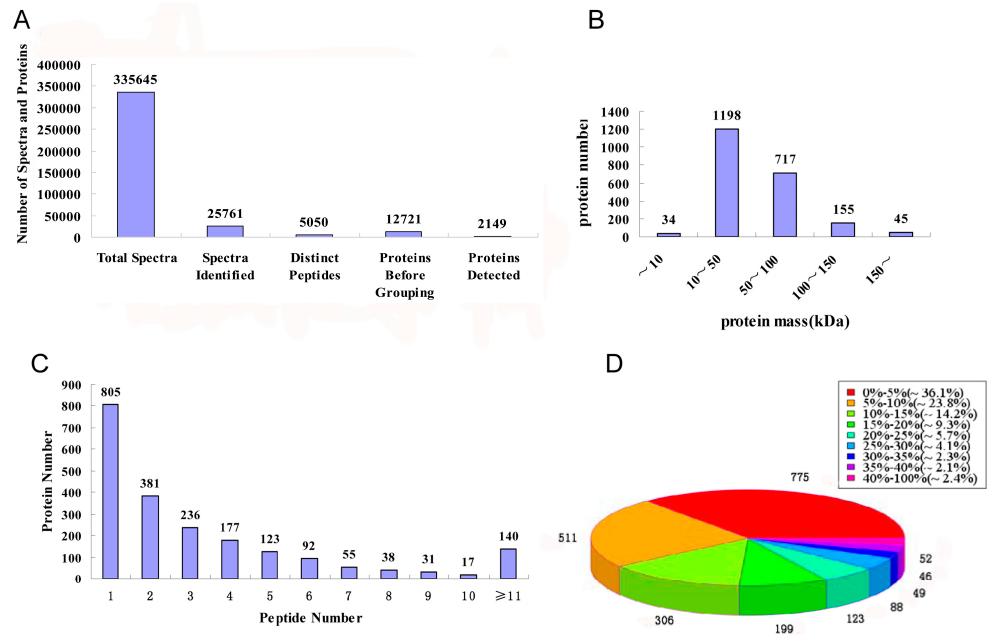
Figure 2. Identification and analysis of the Dipsacus asperoides proteome. ( A ) Total spectra, spectra identified, distinct peptides, proteins before grouping, and proteins detected from iTRAQ proteomic analysis. ( B ) Identified proteins were grouped based on their protein mass. ( C ) Number of peptides that match to proteins as shown by Protein Pilot 5.0. ( D ) According to the protein sequence coverage, the identified proteins were classified into pie charts.